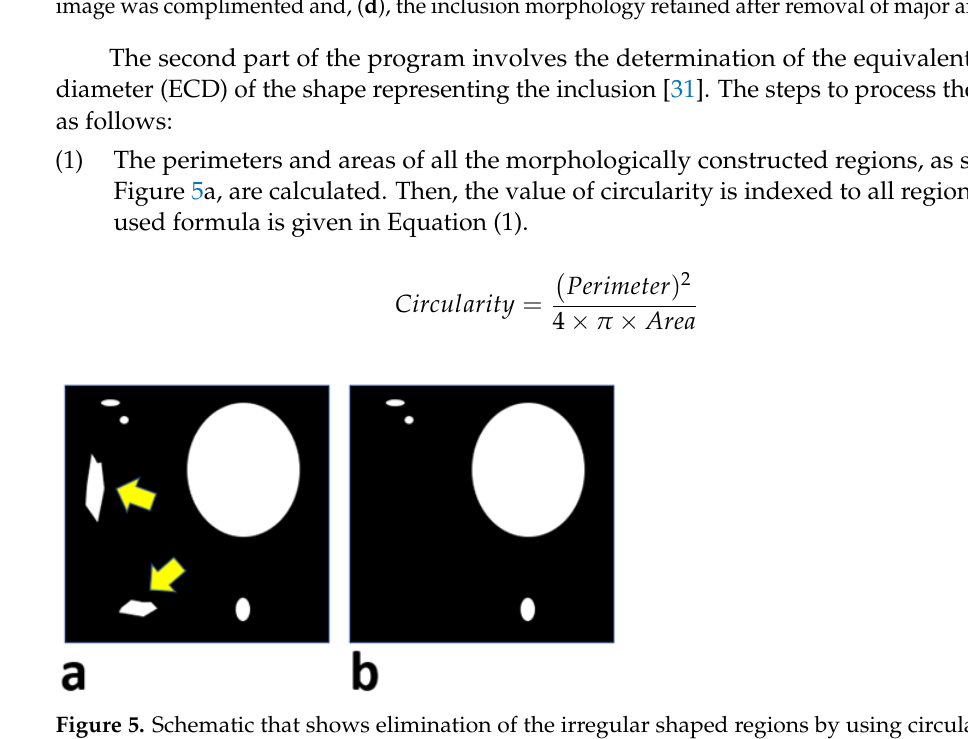
Figure 4. Schematic of the morphological construction of a solid-type inclusion from the greyscale image where, ( a ) represents the solid-like inclusion, ( b ) the inclusion after edges detected, ( c ), the image was complimented and, ( d ), the inclusion morphology retained after removal of major artifacts.